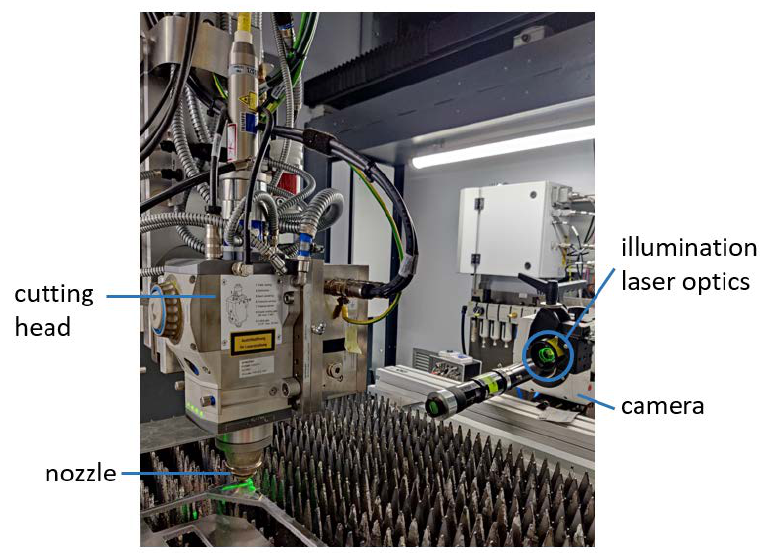
Figure 5. Setup for BOS of the gas jet at the laser cutting machine, consisting of a high-speed camera, an illumination laser, and the cutting head together with a piece of metal from which a slice was cut and removed in order to have a clear view of the striation pattern at the cutting kerf.